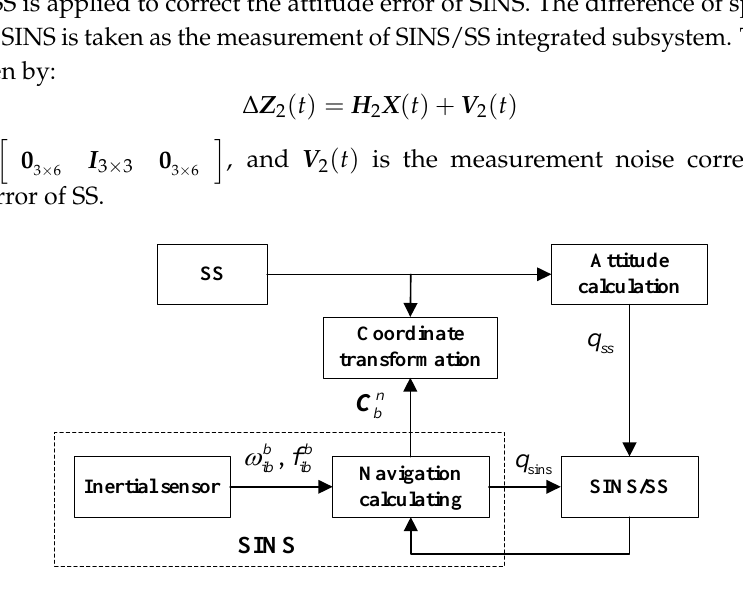
Figure 3. The framework of SINS/SS integrated subsystem.